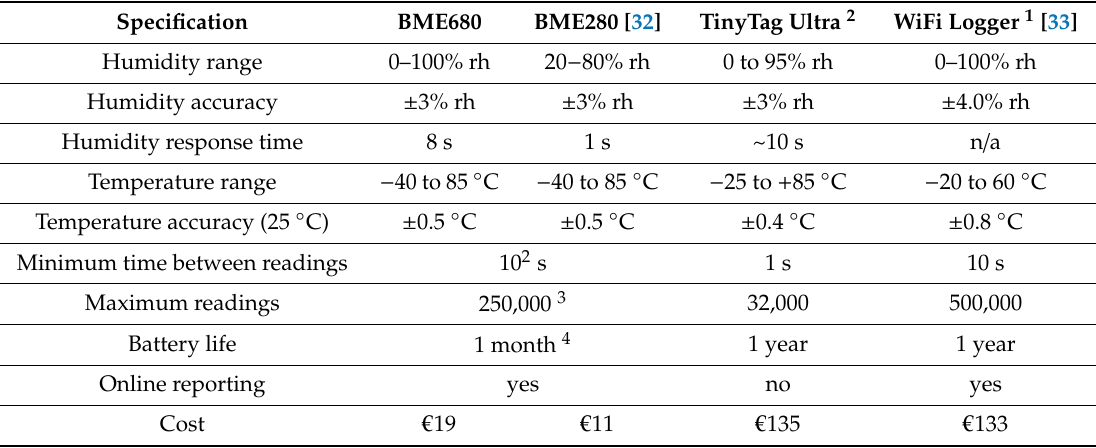
Table 4. Sensor and logging